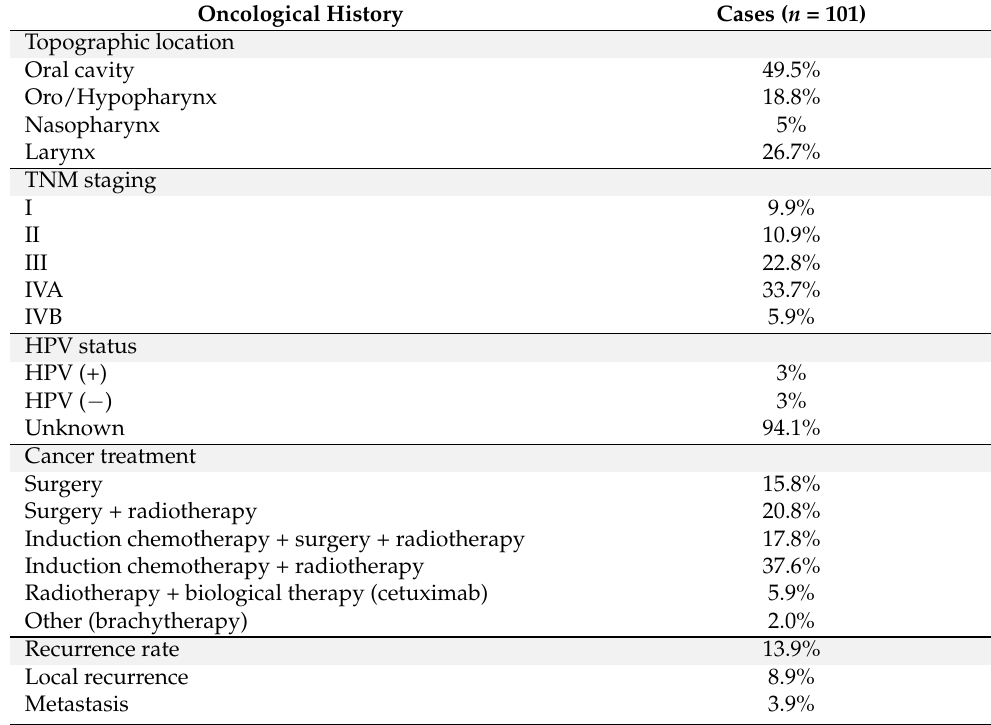
Table 2. Cancer history of patients with head and neck